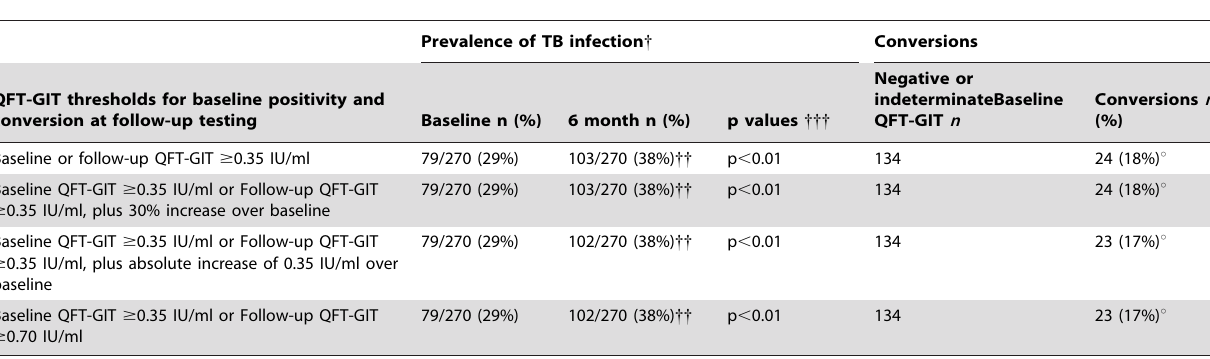
Table 2. Prevalence of TB infection and incidence of conversions using QFT-GIT.